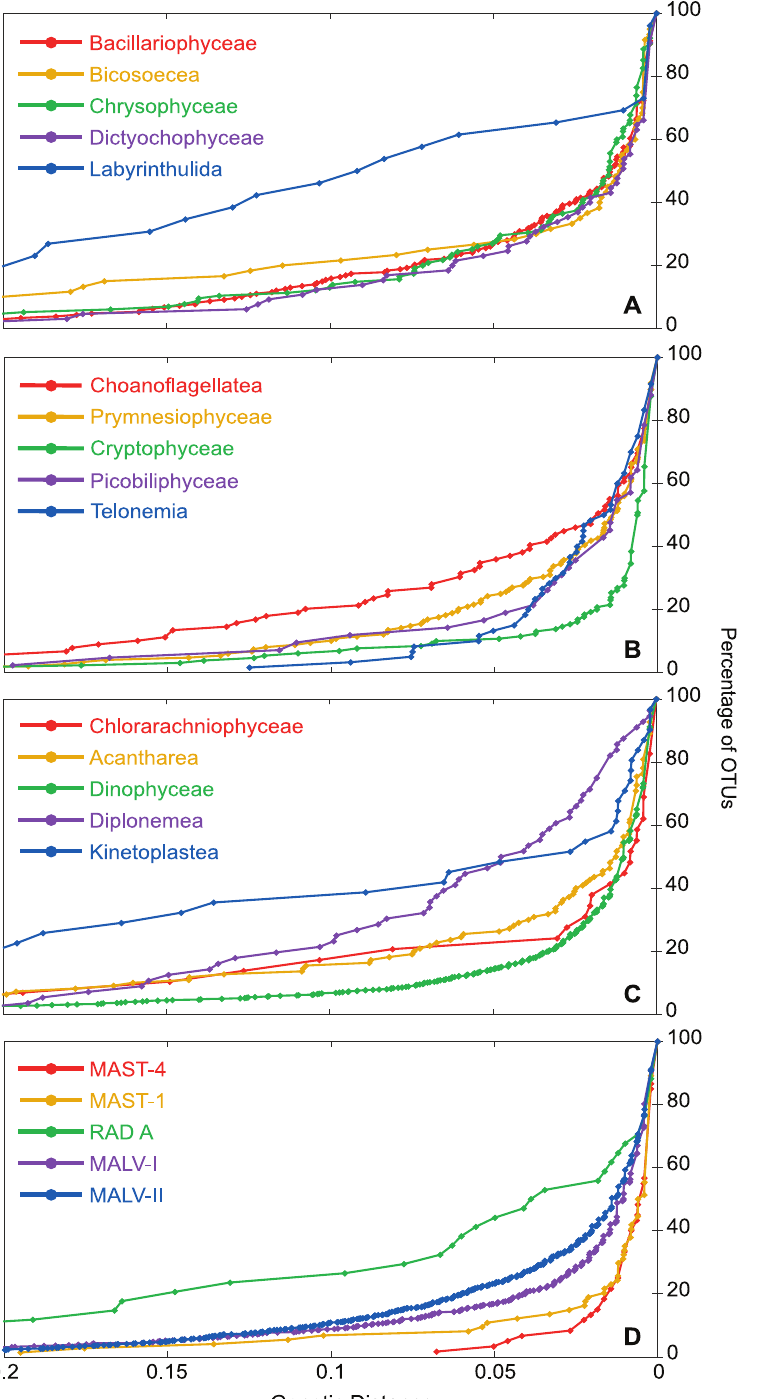
Figure 4. Clustering pattern of several groups of marine protists. The graphs show the percentage of OTUs when sequences are clustered at different genetic distances for several Stramenopiles groups (A), CCTH groups plus Choanoflagellatea (B), Rhizaria and Excavata groups plus Dinophyceae (C) and major ribogroups (D).